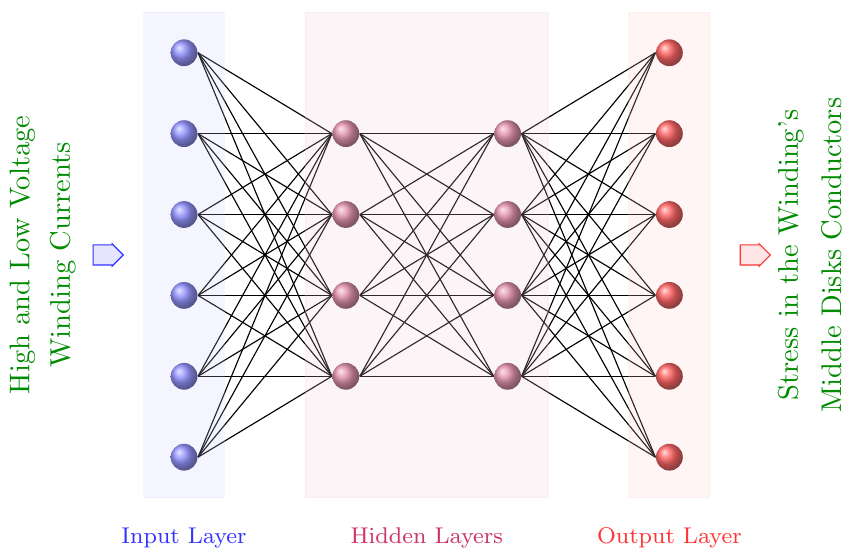
Figure 8. Artificial neural network used to find the stress in the conductors of the windings as a function of the input